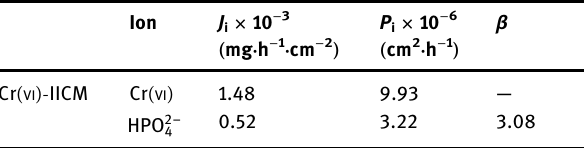
Table 8: Permeability parameters of Cr ( VI )- IICM to anions